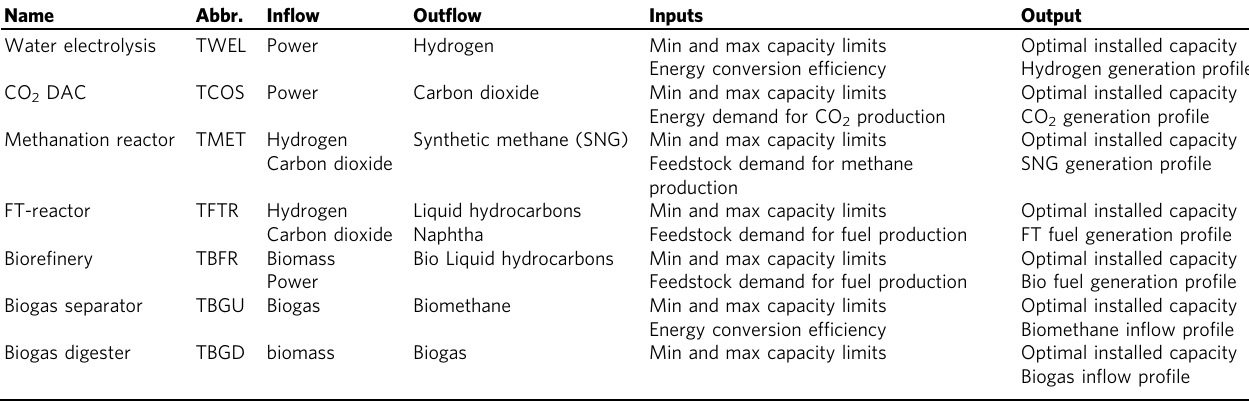
Table 8 Fuel production